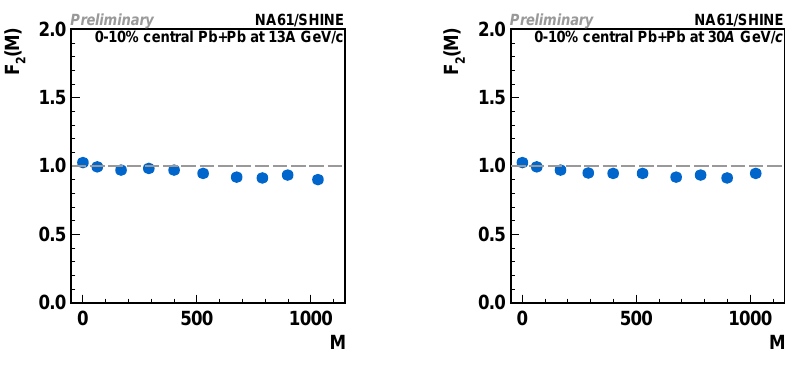
Figure 3. The dependence of the second scaled factorial moment of proton multiplicity distribution on the number of subdivisions in cumulative transverse-momentum space M for 1 ≤ M ≤ 32 2 [22] for central (0-10%) 208 Pb + Pb at 13 A GeV/ c ( left ), central (0-10%) 208 Pb + Pb at 30 A GeV/ c collisions ( right ). Only statistical uncertainties are indicated.